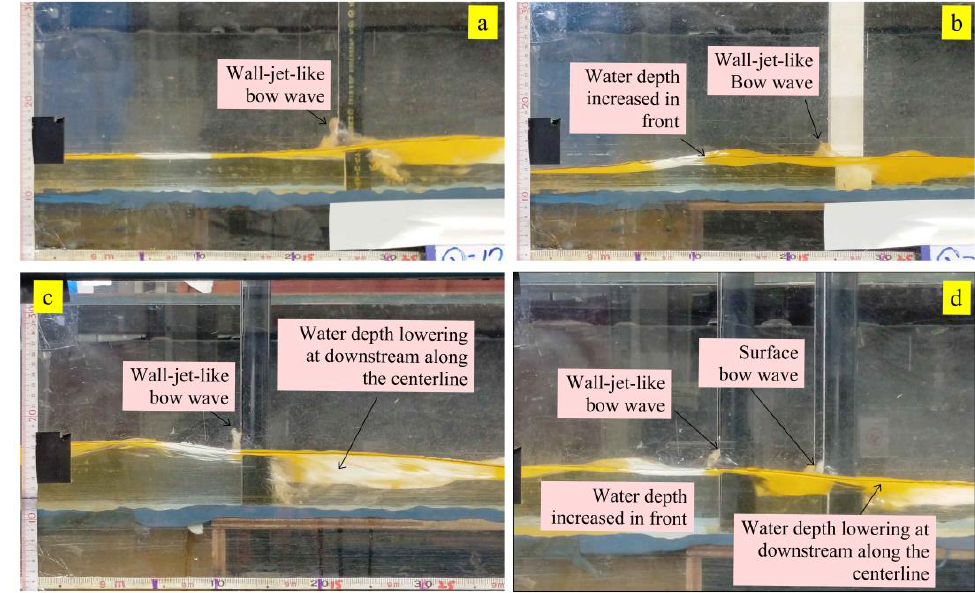
Figure 4. Side view of the supercritical flow passing through emergent cylinders kept inside the experimental flume with a 1/200 bed slope: ( a ) case C1 - CC, ( b ) case C1 - RC, ( c ) case C2–1, ( d ) case C4 - 1.